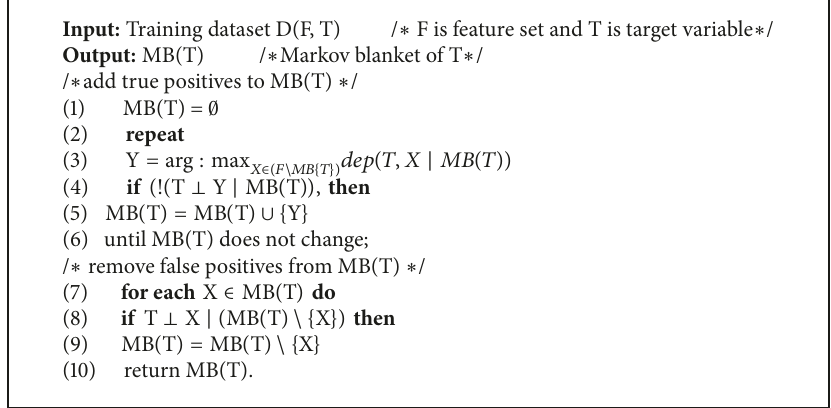
Algorithm 1: The pseudocode of IAMB